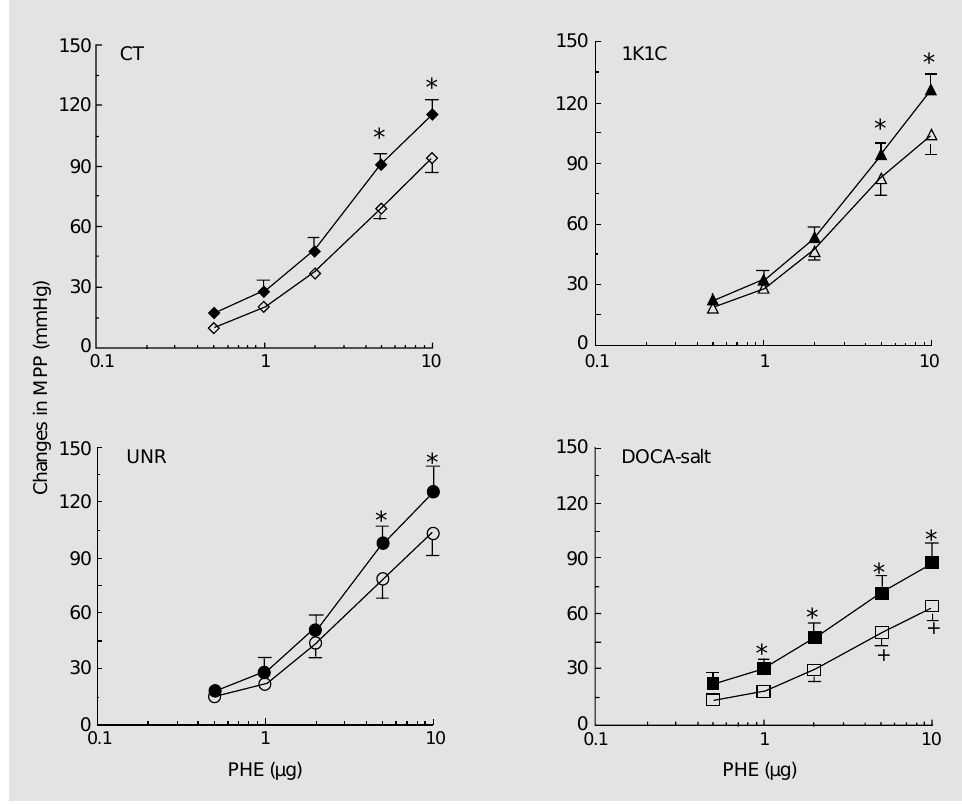
6. Changes in mean per- fusion pressure (MPP) in re- sponse to increasing doses of phenylephrine (PHE) in normo- tensive (control, CT; uninephrec- tomized, UNR) and hypertensive (1K1C and DOCA-salt) rats be-